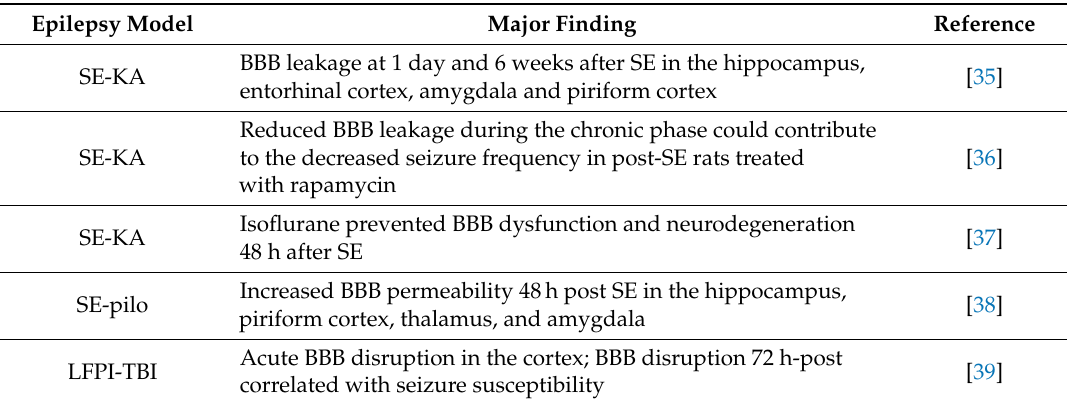
Table 3. List of gadolinium-based contrast MRI studies and potential biomarkers for epilepsy. Epilepsy Model Major